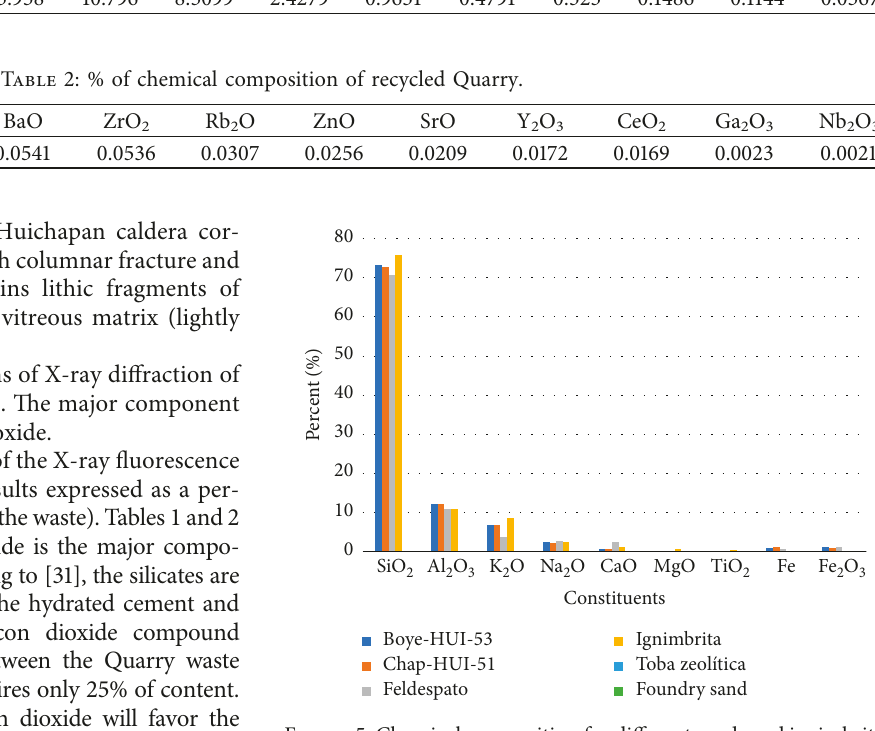
Figure 5: Chemical composition for different sands and ignimbrita (own source).